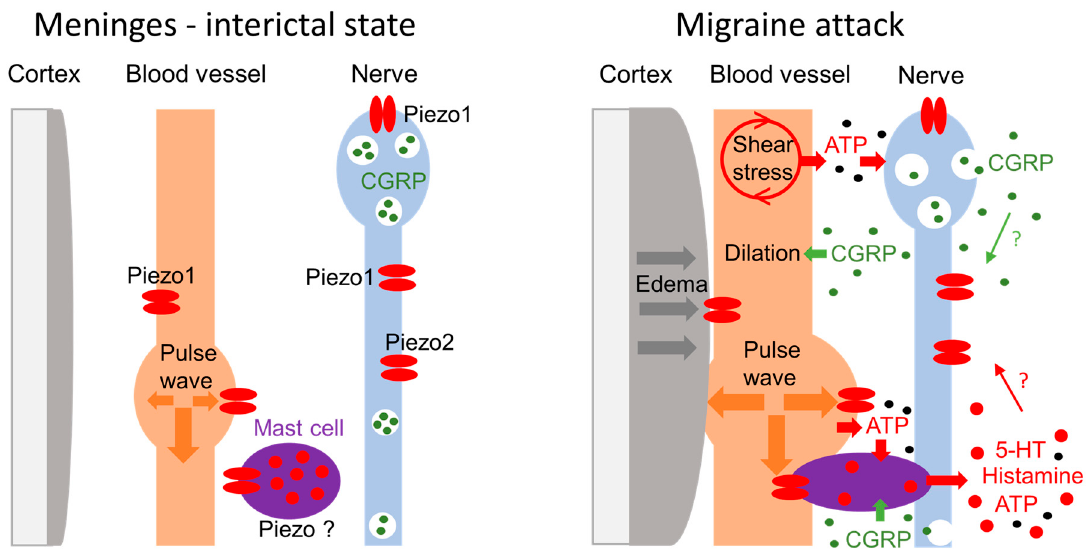
Figure 2. Schematic presentation of the key elements of the trigeminovascular system comprising meningeal blood vessels, local mast cells and trigeminal nerve fibers before and during migraine attack. Left: In the interictal state, before attack, there are only slight pulsations of meningeal vessels with the minimal activation of vascular Piezo1 channels or Piezo1 and Piezo2 channels in nerve fibers. Right: During migraine attack, which is often associated with brain oedema and CGRP-induced dilation of vessels, the extracellular space is reduced, promoting more close contact between pulsating vessels, nerves and nearby mast cells. The shear stress in dilated vessels and enhanced vascular pulsations promote mechanosensitive ATP release from the endothelial cells. Mechanical stimulation of calcium permeable Piezo channels in nerve fibers by pulsating vessels promotes neuronal CGRP release. CGRP and ATP can degranulate mast cells directly. In addition, the fraction of mast cells contacting vessels, is directly mechanically activated by blood pulsations. Activation of mast cells induces release of a plethora of pro-nociceptive compounds such as serotonin, histamine, leukotrienes, prostaglandins, ATP, and nitric oxide, further exciting the nociceptive fibers and promoting more CGRP release. All these pro-inflammatory compounds, in long run, together with CGRP, promote neuroinflammation, neuronal sensitization leading to long-lasting pulsating